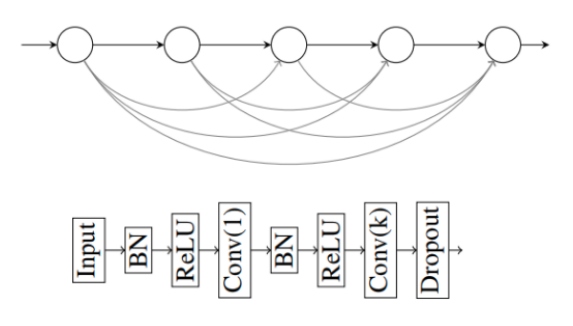
Figure 2. The DenseNet architecture of the 2D masked